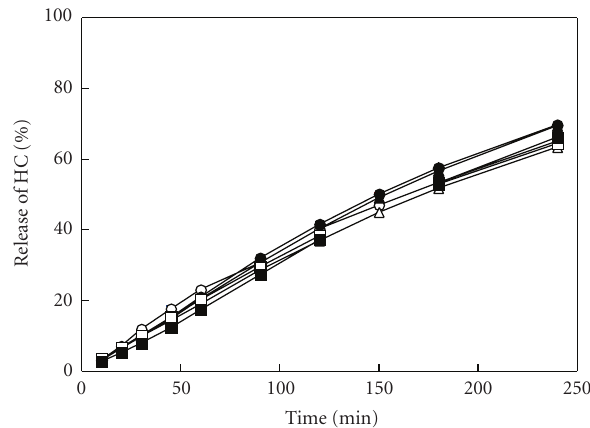
Figure 5: Release profiles of HC from Alg-Ca or CAP in physio- logical saline. Open circles: Alg-Ca (1.5% Alg, 0.1 M CaCl 2 ); open squares: Alg-Ca (1.5% Alg, 0.2 M CaCl 2 ); open triangles: Alg-Ca (2.0% Alg, 0.1 M CaCl 2 ); closed circles: CAP (1.5% Alg, 0.5% AP, 0.1M CaCl 2 ); closed squares: CAP (1.5% Alg, 0.8% AP, 0.2 M CaCl 2 ); closed triangles: CAP (2.0% Alg, 0.5% AP, 0.1M CaCl 2